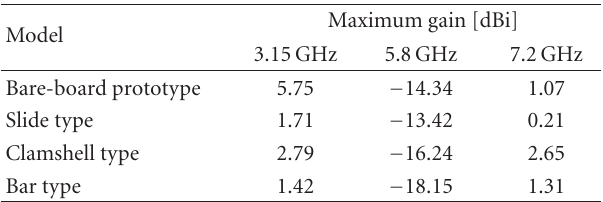
Table 1: Absolute gain of the proposed antenna for the various mobile